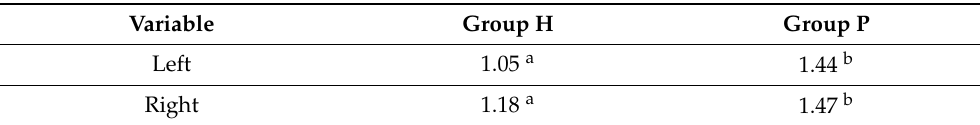
Table 1. Mean thickness of DJC in the Group H and P. Values are expressed as mean and standard deviation. Statistical significance was set at p < 0.05. Variable Group H Group P Left 1.05 a 1.44 b Right 1.18 a 1.47 b Different letters in the same row indicate significantly different results ( p < 0.05).